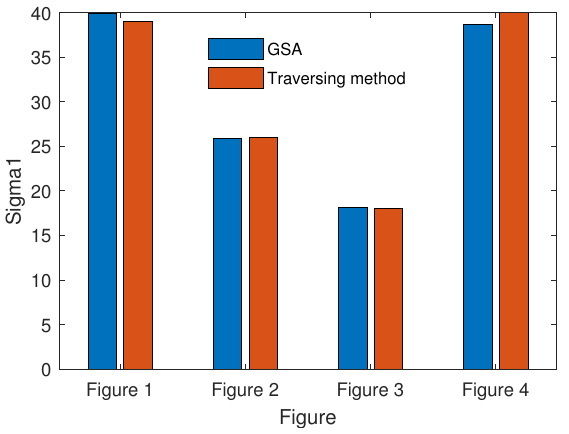
Figure 12. Comparison of the optimal values of optimization and traversal.